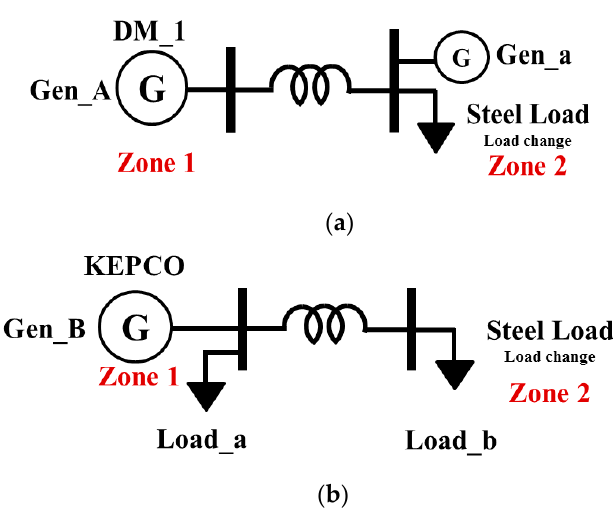
Figure 10. Model for simulation: ( a ) 1-bus stand-alone model; ( b ) 1-bus network model.